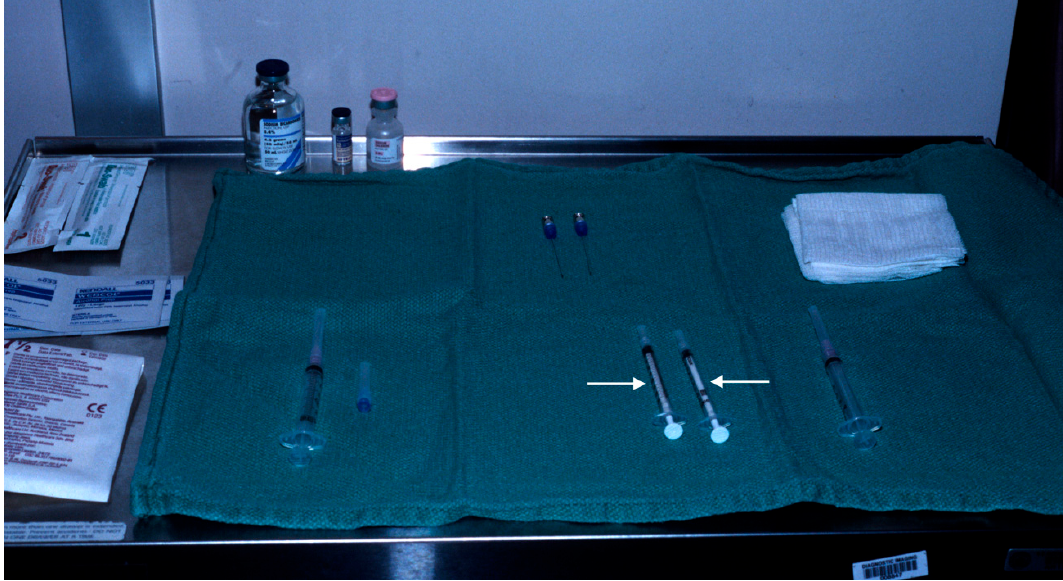
Figure 4. Procedure tray for mammographically-guided SLNB with two tuberculin syringes (arrows).